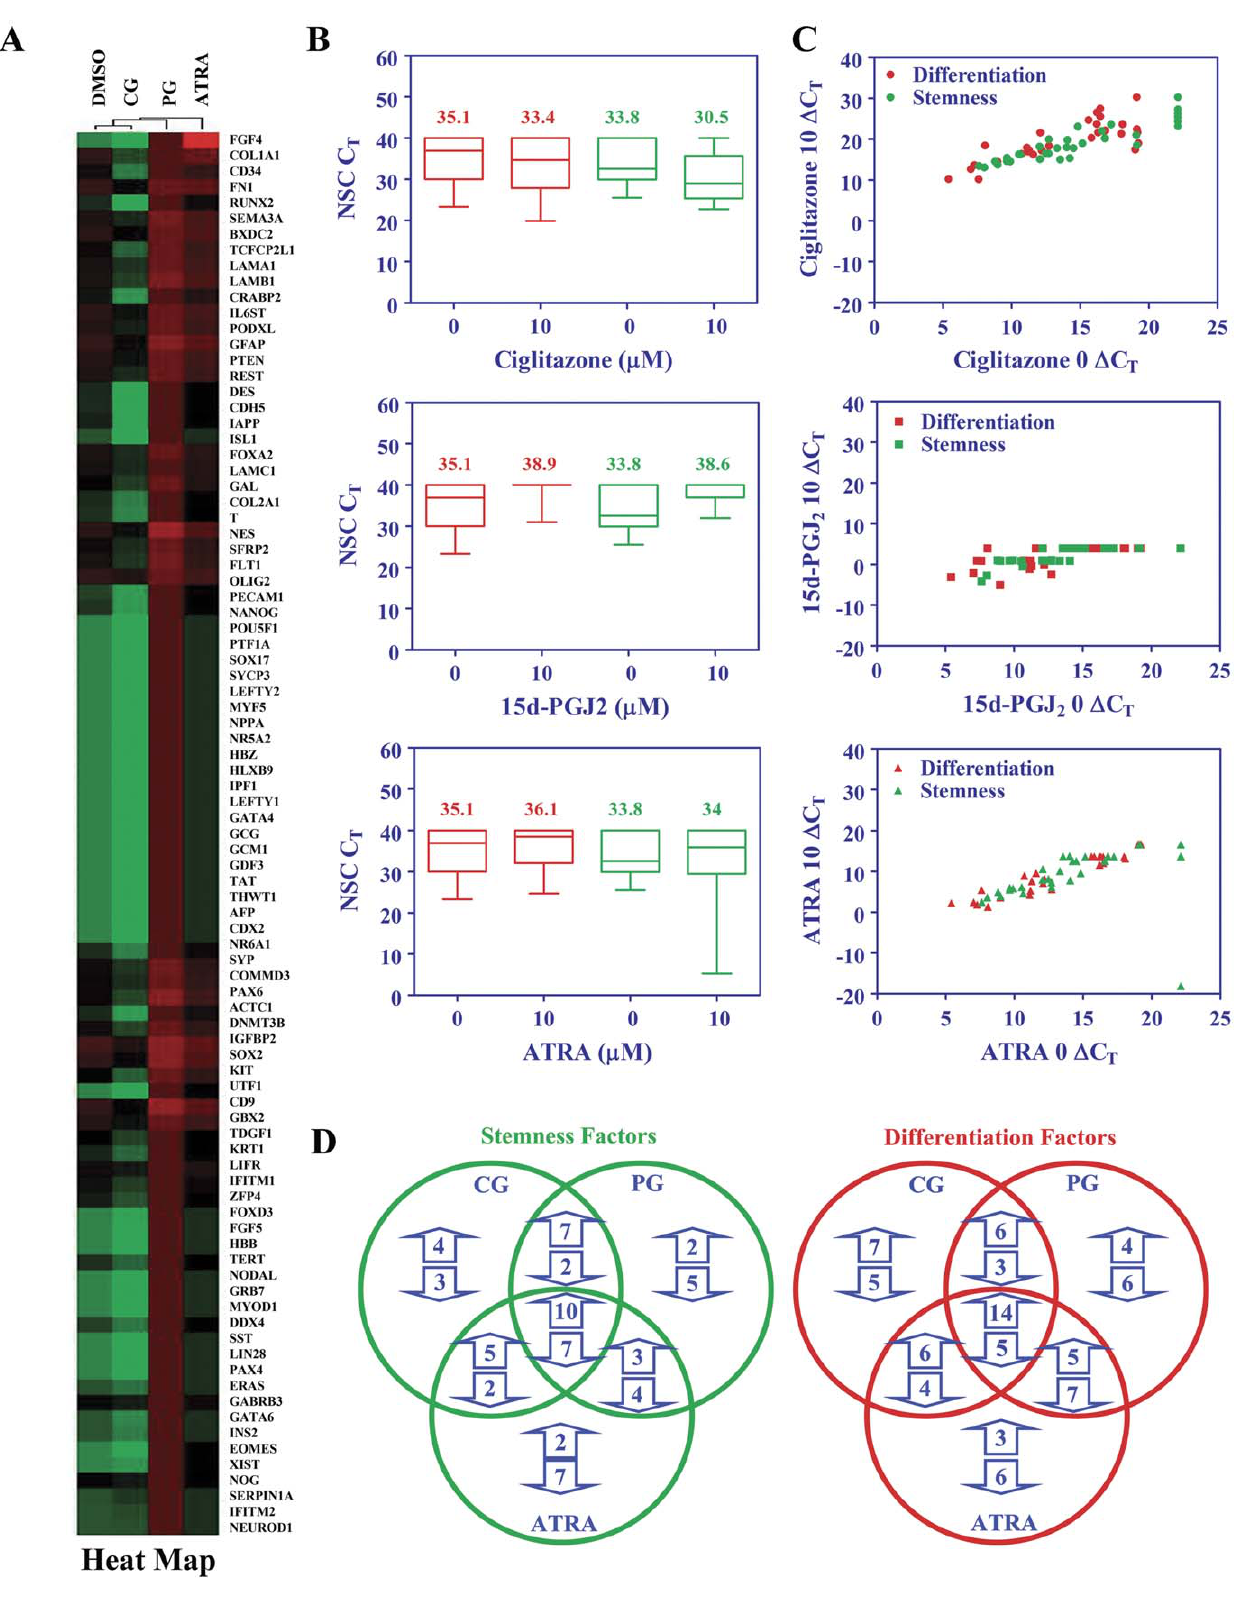
Figure 6. Regulation of stemness and differentiation genes by PPAR c agonists in NSCs. NSCs were cultured in NBM + B27 with 10 ng/ml EGF + bFGF in the presence of 0 or 1 m M ciglitazone, 15d-PGJ2 or ATRA for 3 days and the stem cell gene expression analyzed by qRT-PCR. (A) Heat map showing the expression levels of stemness and differentiation genes in NSCs treated with agonists compared to control. (B) Box plots showing the C T values of differentiation (Red) and stemness (Green) genes in NSCs treated with agonists compared to control. (C) Scatter plots showing D C T